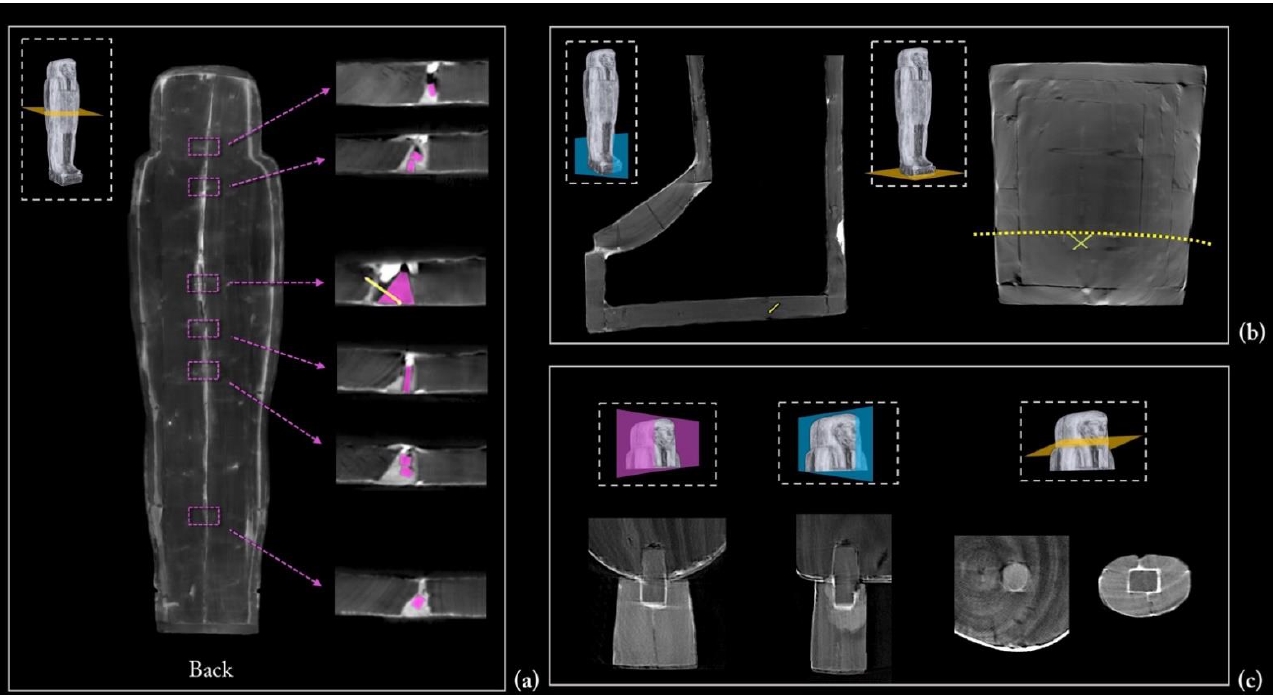
Figure 18. ( a ) The modern restoration interventions of the underside of the floor board, ( b ) foot board, and ( c ) beard.